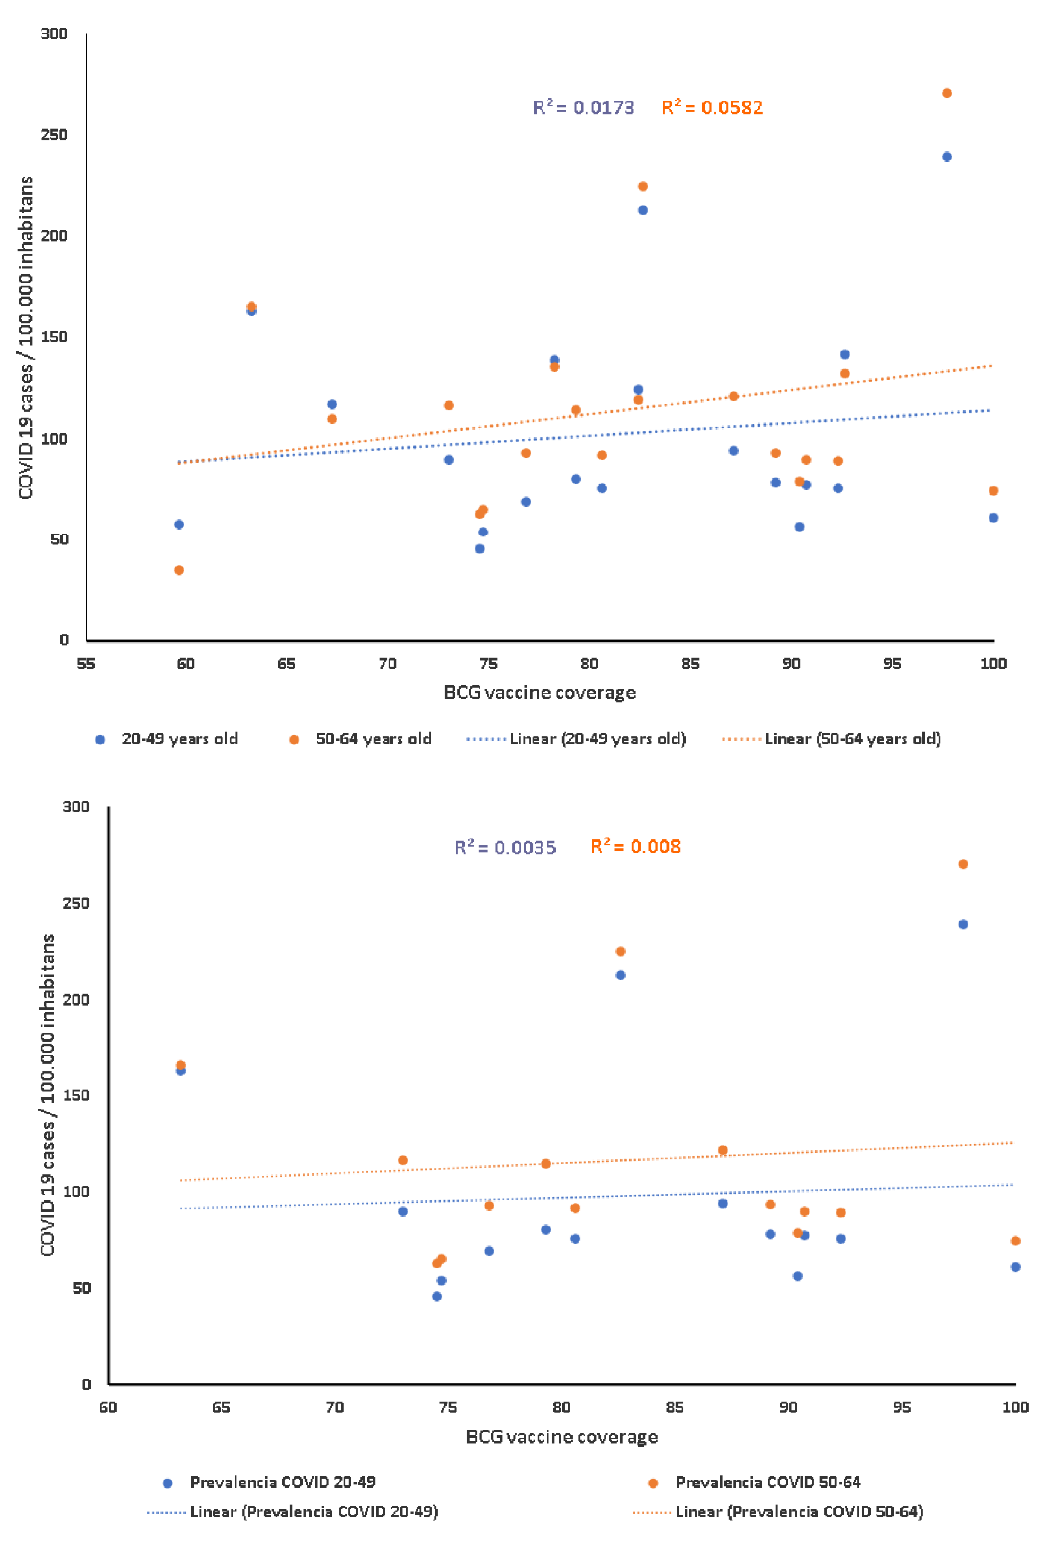
Figure 3. Correlation between BCG vaccine coverage in 1980 (upper panel), provinces with less than 80% of BCG vaccine coverage in 1980 (lower panel), and COVID-19 cases adjusted for 100,000 inhabitants, in August 2020, by age group.